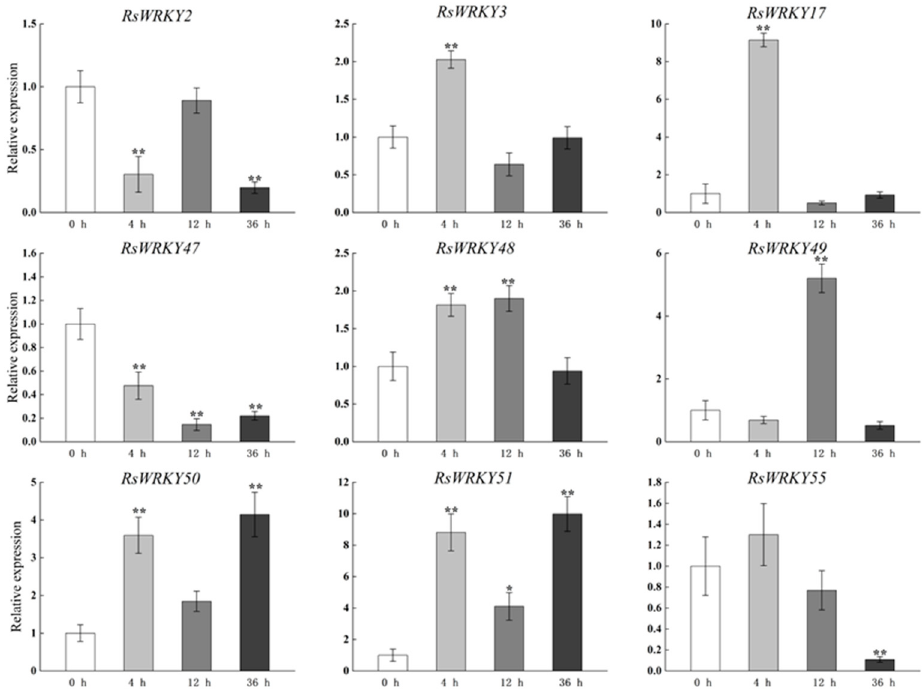
Figure 6. Expression profiles of RsWRKY genes under 200 µM MeJA treatment. Gene expression at 0 h was normalized as “1.” Data are mean ± standard deviation (SD), calculated from three biological replicates, and vertical lines represent the standard deviation. * and ** mean significant difference at p < 0.05 and p < 0.01, respectively.